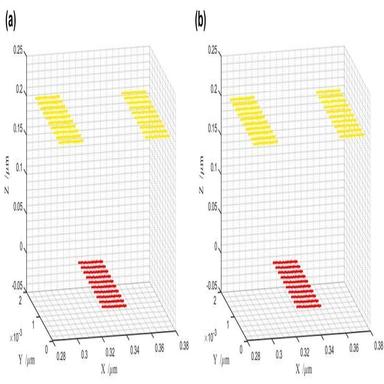
Data visualization of the evaluated planes in Experiment 3: (a) The evaluated planes; (b) The results after levelling the upper two yellow planes. (For interpretation of the references to color in this figure legend, the reader is referred to the Web version of this article.)